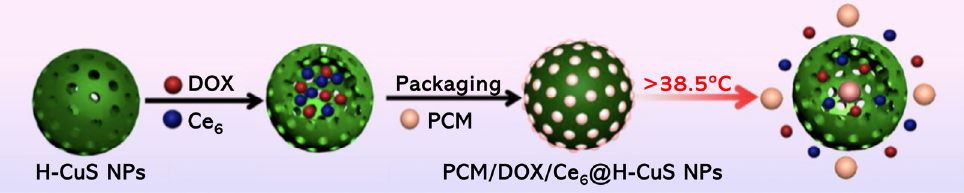
Figure 10. Representation of the thermo-responsive nanostructure, based on hollow mesoporous copper sulphide NPs (PCM/DOX/Ce6@H-CuS NPs), for trimodal therapy (reproduced from Reference [81] with permission from the American Chemical Society).